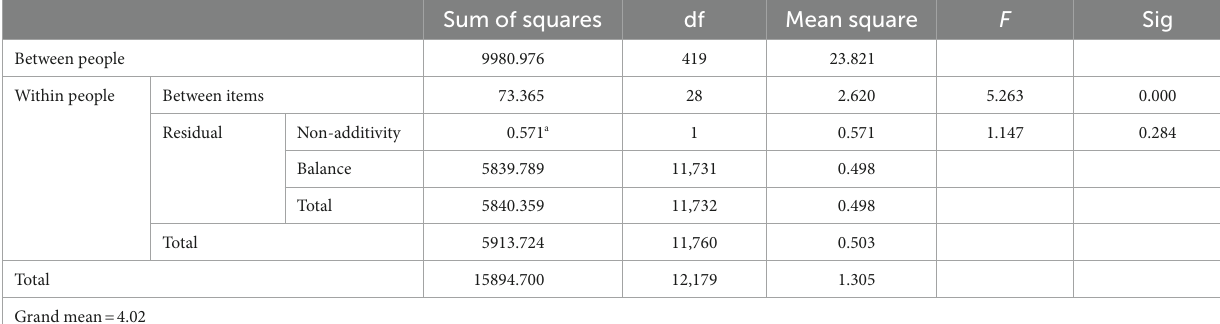
TABLE 7 ANOVA with Tukey’s test for non-additivity.